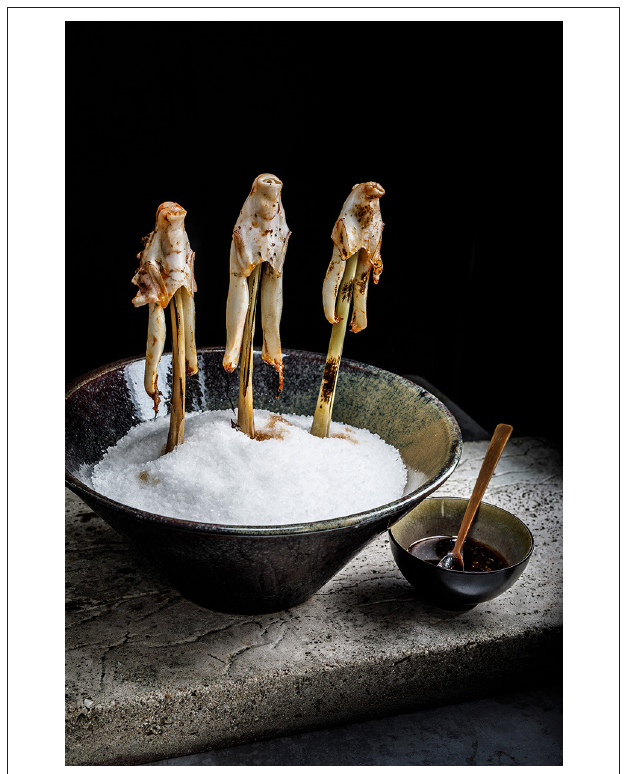
FIGURE 3 | A semi-classical Cambodian-inspired dish of marinated and grilled siphon and retractor muscles of Loligo forbesii on lemon grass. Photo: permission by and courtesy of Jonas Drotner